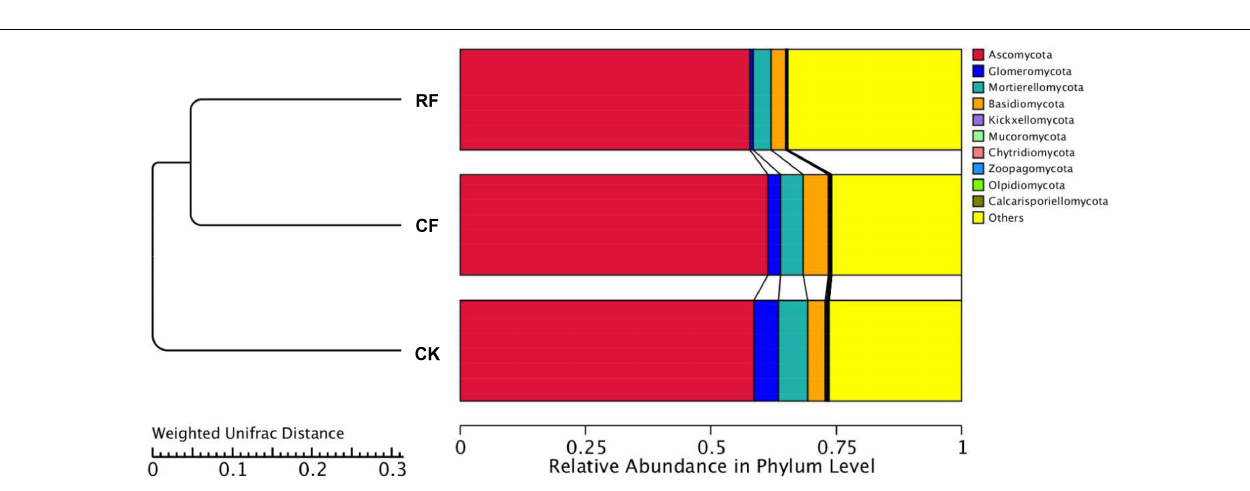
between soil nutrition and fungal community structure after